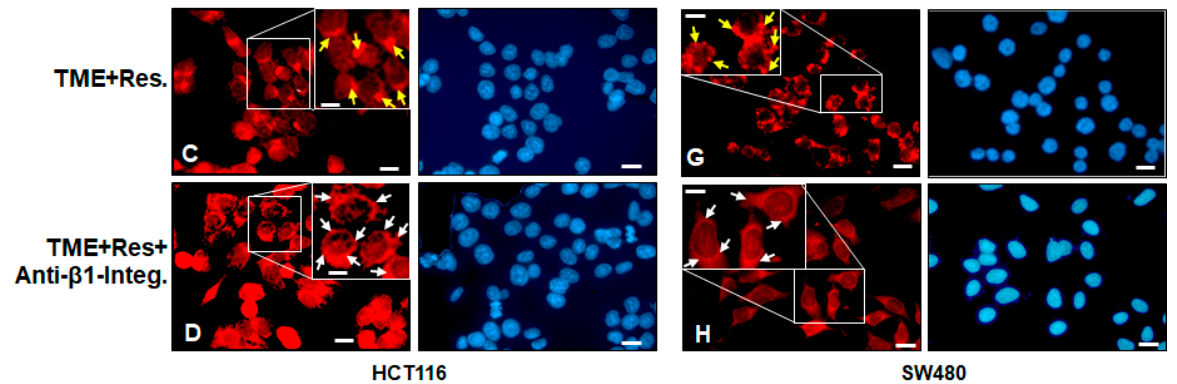
Figure 1. Immunofluorescence microscopy visualization of β 1-integrin receptors under resveratrol challenge on the surface of HCT116 and SW480 cells in the TME. β 1-integrin immunolabeled (white arrows) and DAPI-stained nuclei from untreated basal control ( A , E ); TME-grown ( B , F ); resveratrol- treated (5 µ M) ( C , G ), and further addition of anti- β 1-integrin (2 µ g/mL) ( D , H ) HCT116 and SW480 cells. Yellow arrows = change in distribution pattern of β 1-integrin receptors. Microscope: Leica DM 2000. Magnification × 600; scale bar = 30 µ m. Insets: magnification: × 1200; scale bar = 15 µ